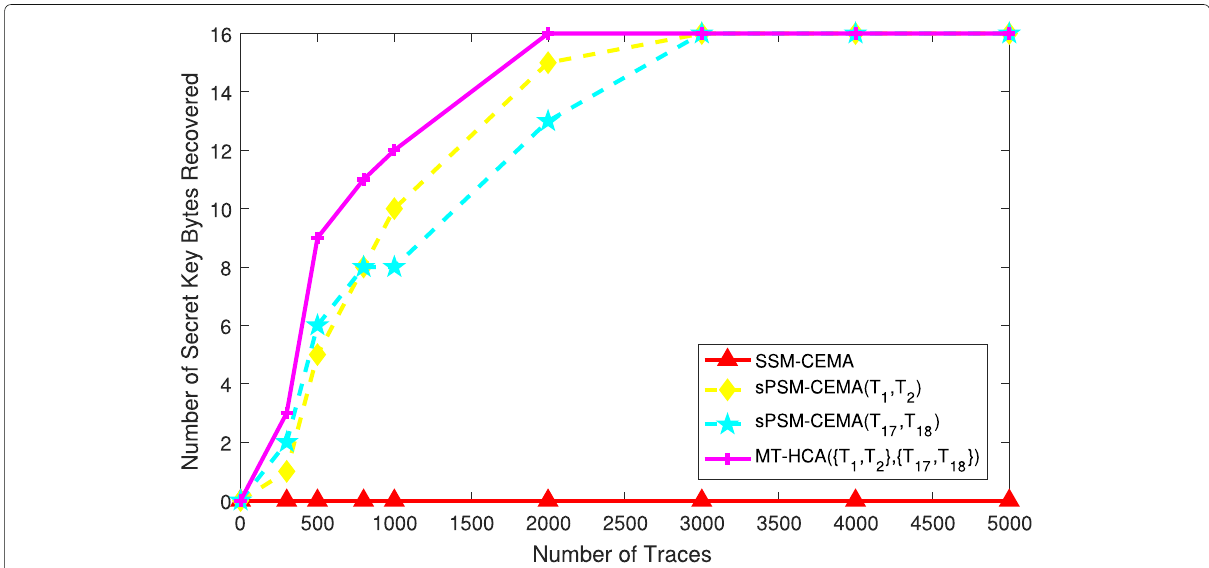
Fig. 13 The experimental results of SSM-CEMA, sPSM-CEMA and MT-HCA in T 32 G - S 1 G encryption mode